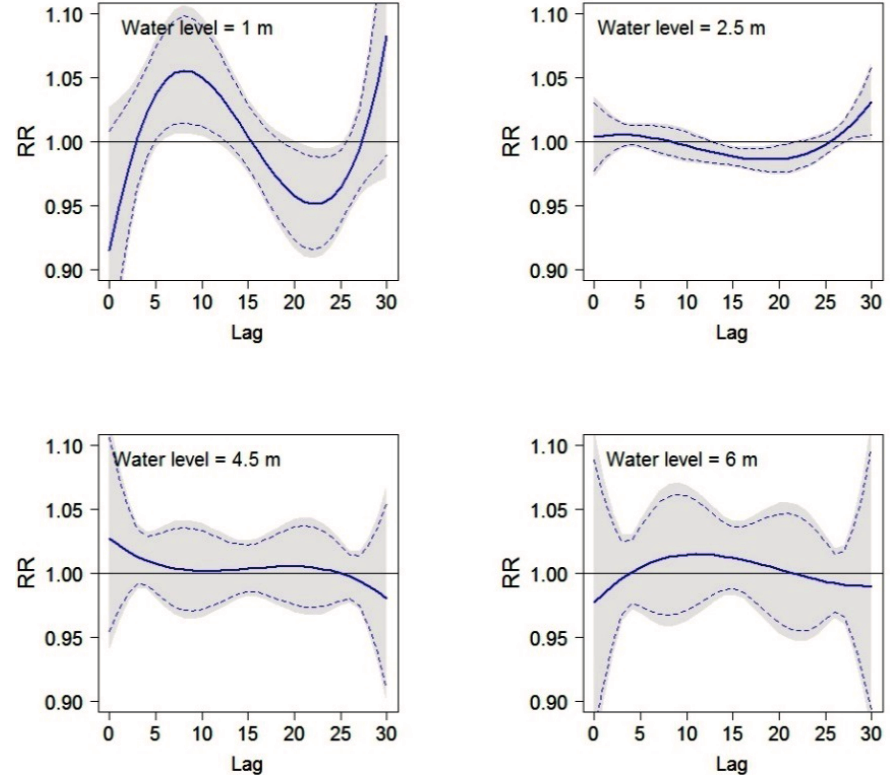
Figure 9. Plots of the relative risk of all-cause mortality at water levels of 1 m, 2.5 m, 4.5 m and 6 m along lags, with reference at the median water level using distributed lag non-linear models. Outputs are adjusted for trend, season, and day of the week. Grey areas display upper and lower 95% confidence intervals; dashed lines display 90% upper and lower 95% confidence